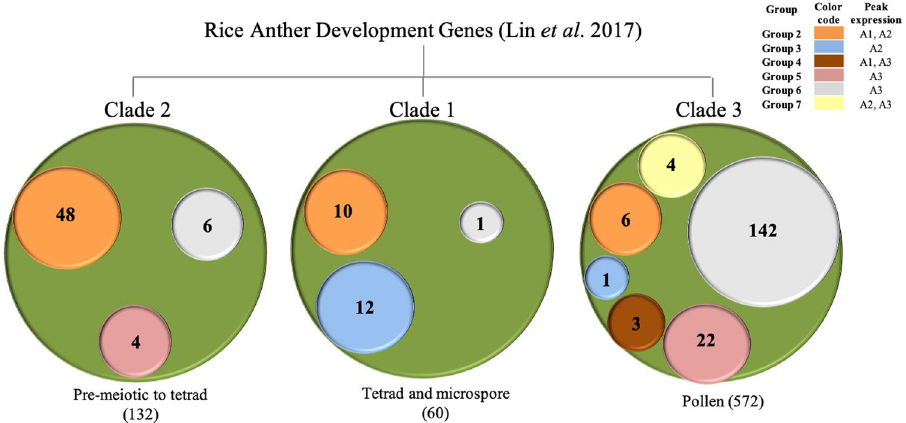
Figure 4. Comparison of sorghum and rice anther transcriptome. Lin and co-workers 82 identified differentially expressed genes (DEGs) in several male sterile mutants of rice and divided them into three clades based on stage specific expression. Clade 2, 1, and 3 represent premeiotic to tetrad, tetrad and microspore, and pollen-related genes, respectively. A comparison with different groups of DEGs in our data highlighted interesting parallels between two studies. Based on orthology, the clade 2 genes of rice showed maximum common genes with group 2 of our data; clade 1 showed common genes with groups 2 and 3; and clade 3 showed maximum common genes with groups 5 and